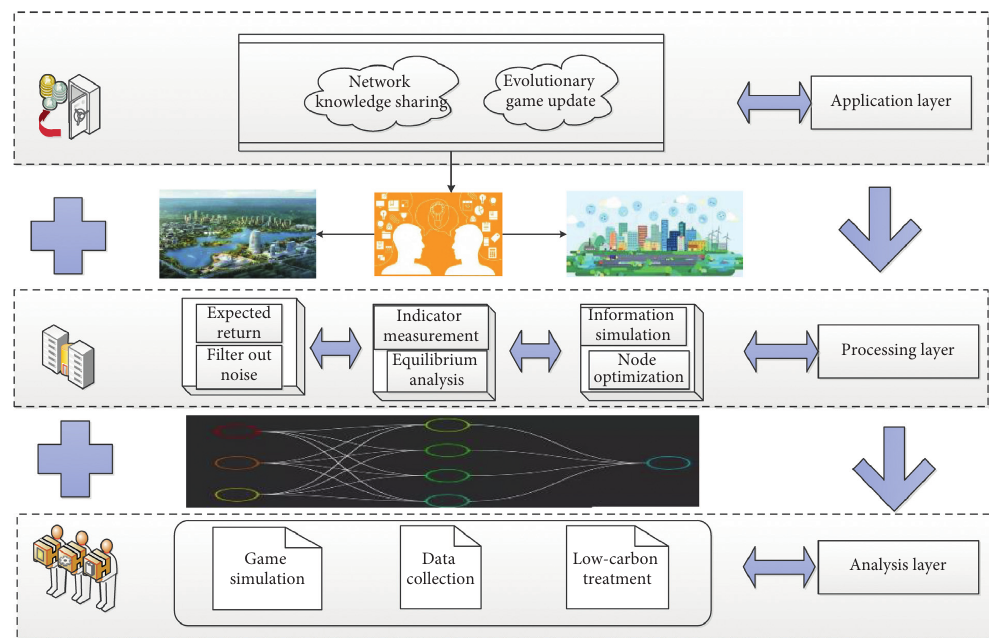
Figure 3: Framework structure of network knowledge sharing model.